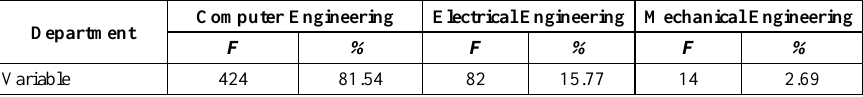
Table 4. Distribution of university students by